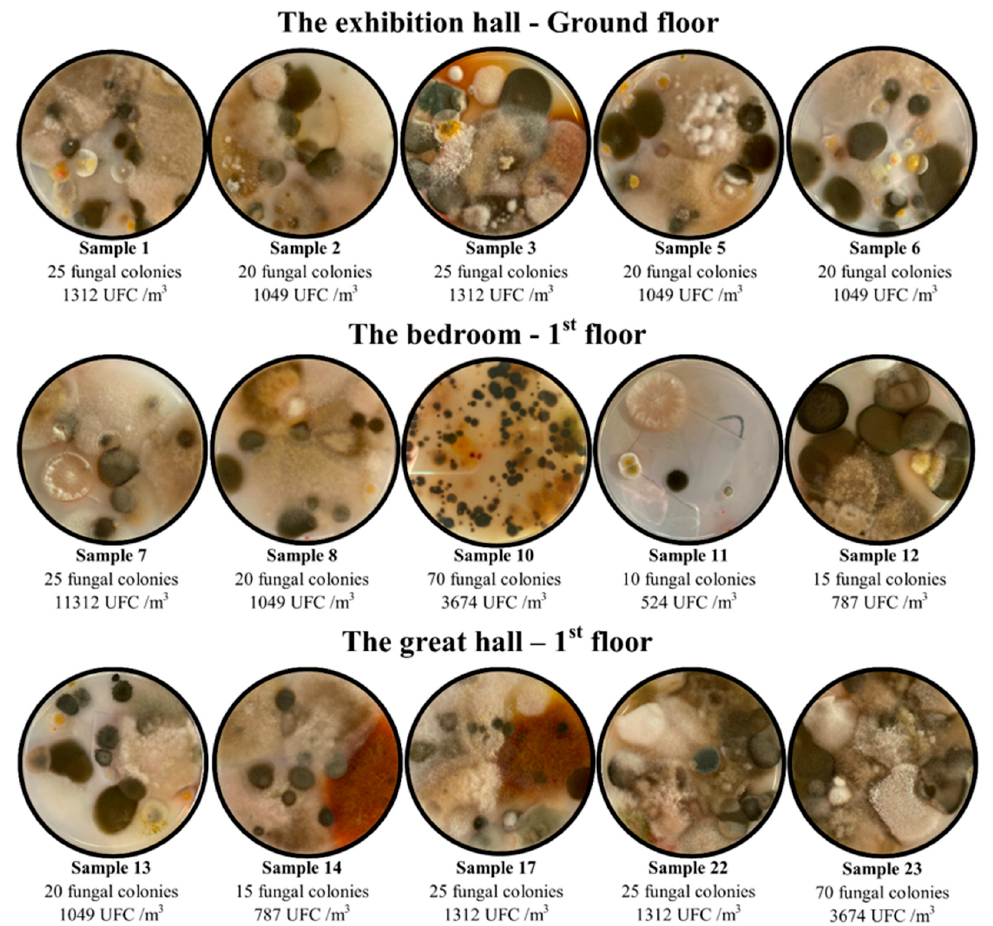
Figure 7. Appearance of fungal colonies at 7 days after sampling from the indoor air in the three rooms in Darvas-La Roche House.